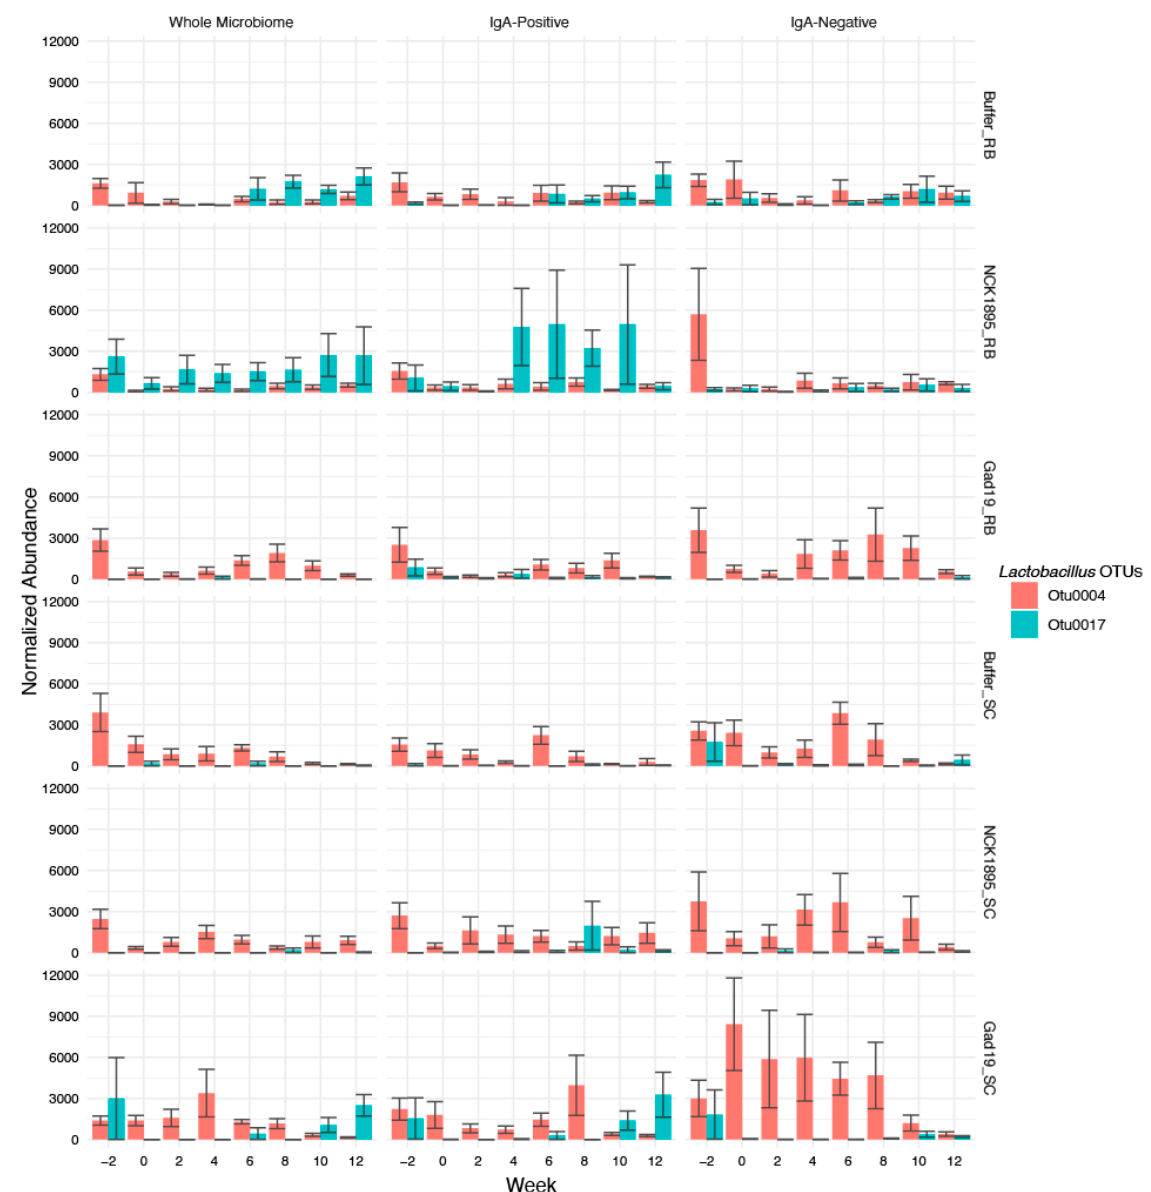
Figure 7. The normalized abundances of the most abundant OTUs in the Lactobacillus genus are shown for the whole microbiome (first column), IgA-positive microbiome (middle column), and IgA-negative microbiome (last column). The values are based on the normalized abundances calculated using cumulative sum scaling, as described in Section 2. Bars represent the mean count for each group at each timepoint, with error bars showing the standard error.